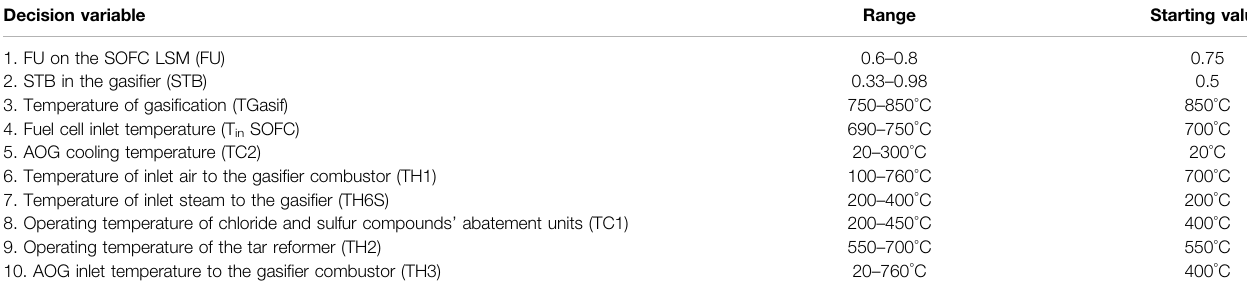
TABLE 5 | Decision variables for optimization (between brackets, reference in Supplementary Figure S7 ). Decision variable Range Starting value